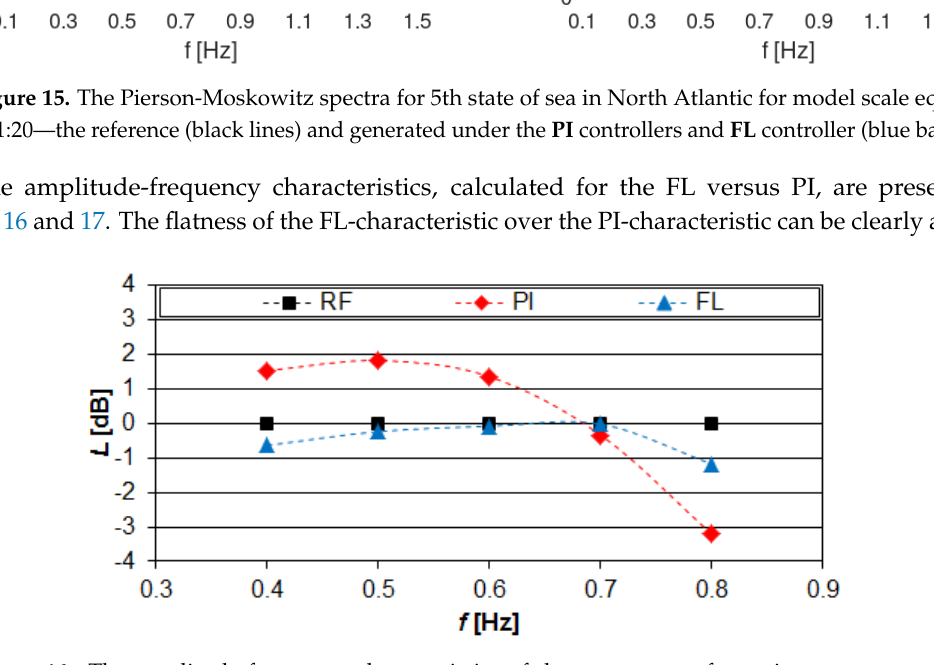
Figure 16. The amplitude-frequency characteristics of the energy transformation process carried out with the FL controller versus the PI controllers for the desired reference RF —the progressive sinusoidal waves.